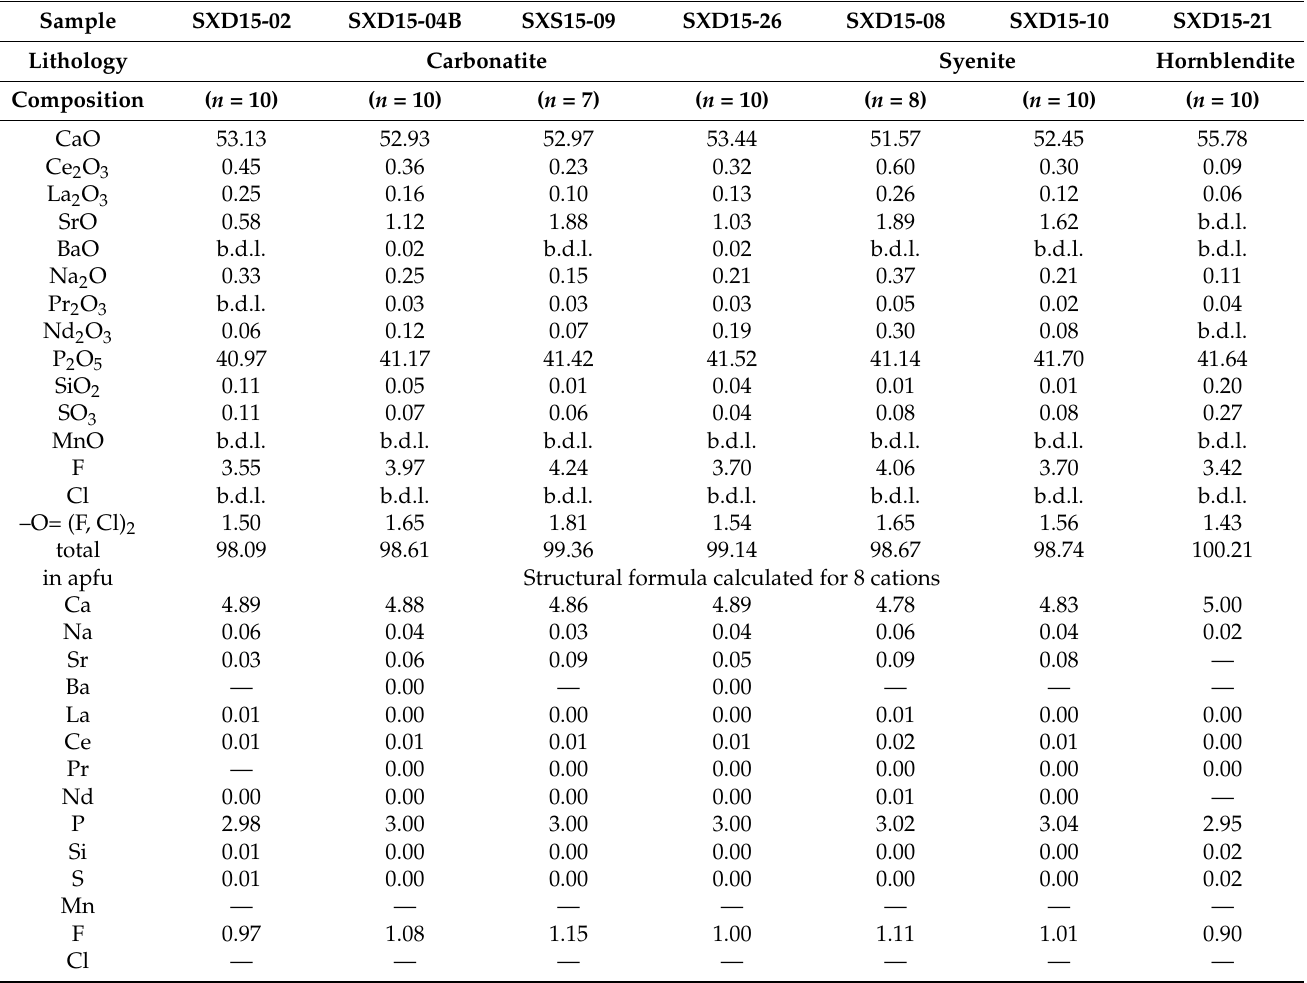
Table 1. Average apatite compositions obtained by